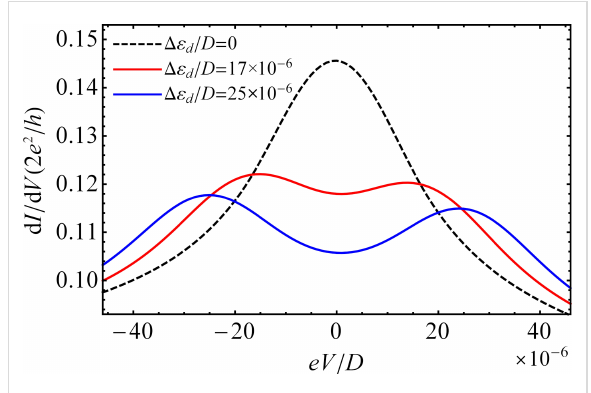
Figure 8: Differential conductance d I /d V as a function of the bias voltage eV for different values of the Zeeman energy at temperature T / D = 5 × 10 − 6 . The remaining parameters are the same as those in Figure 5.